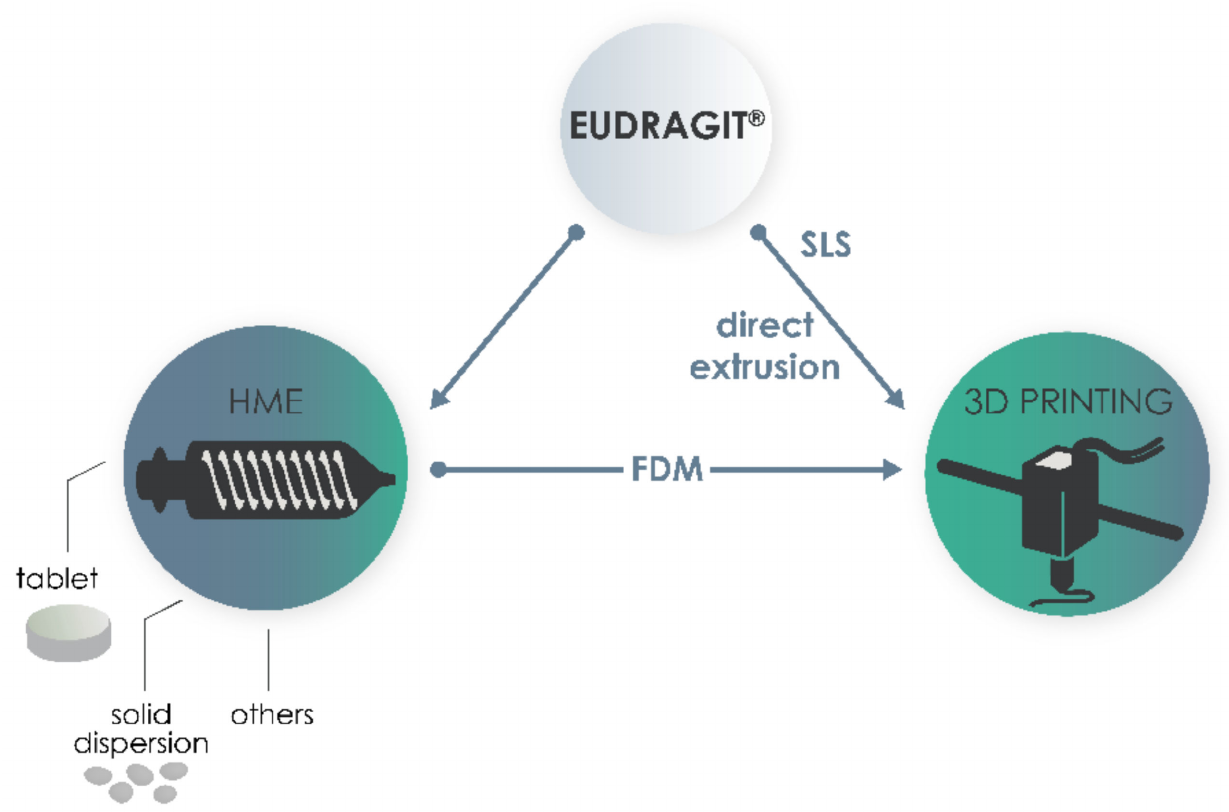
Figure 2. Decision path used to classify articles in the scope of this review. FDM, fused deposition modelling; HME, hot melt extrusion; SLS, selective laser